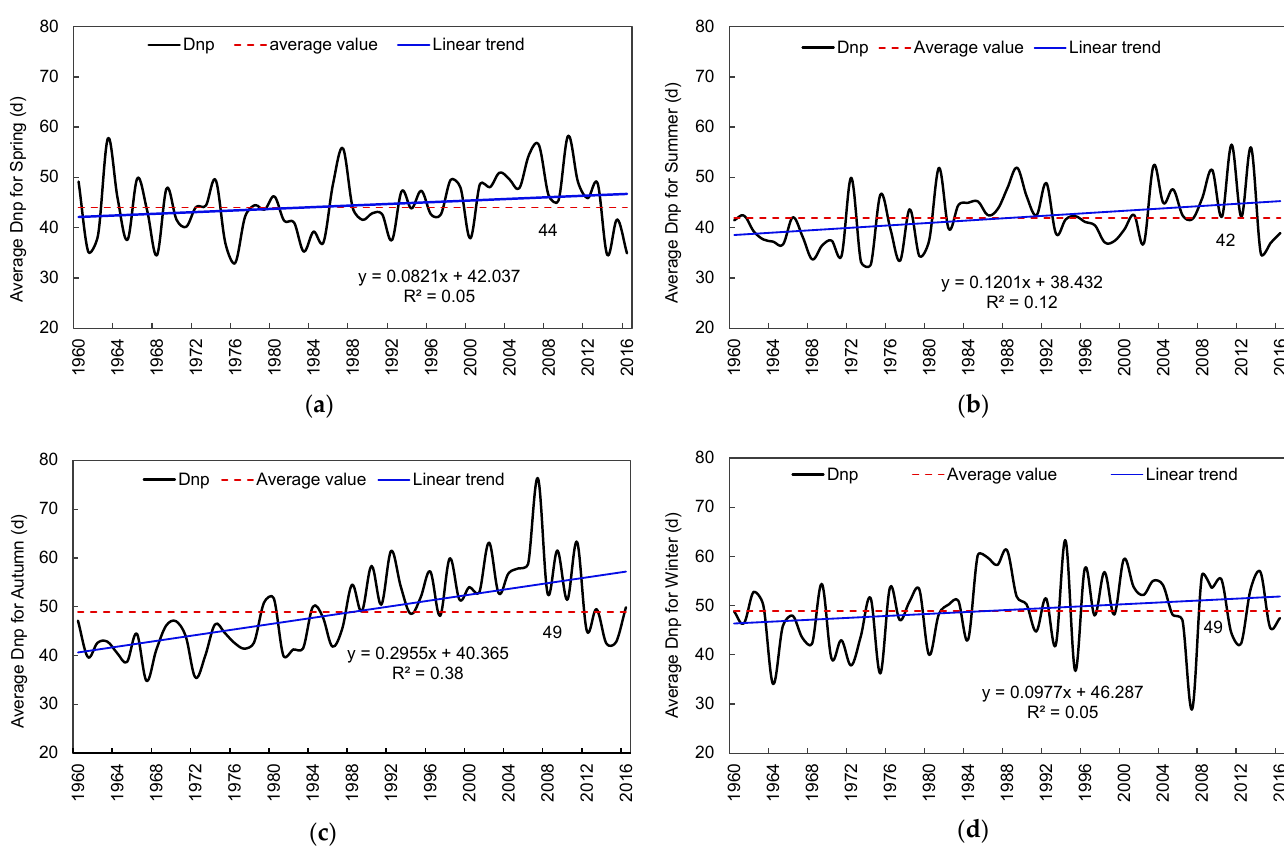
Figure 5. The spatial variations of seasonally average Dnp in ( a ) spring, ( b ) summer, ( c ) autumn, ( d )